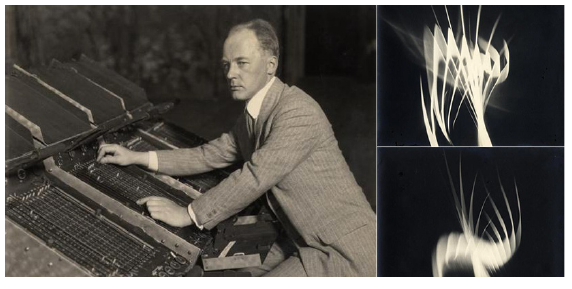
FIGURE 1 | Thomas Wilfred with the Clavilux(left).